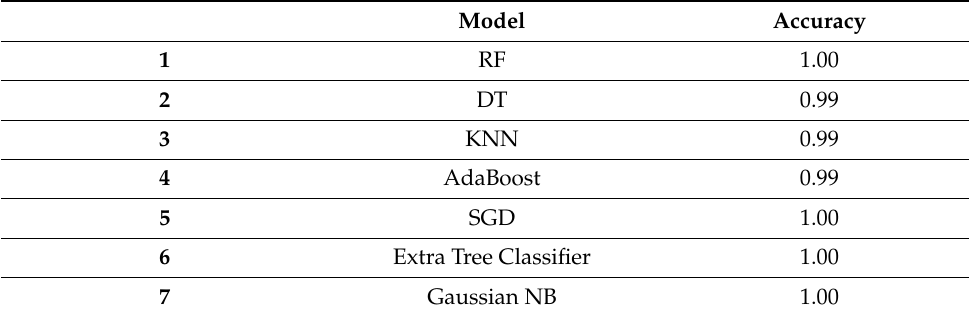
Table 2. Illustration of the